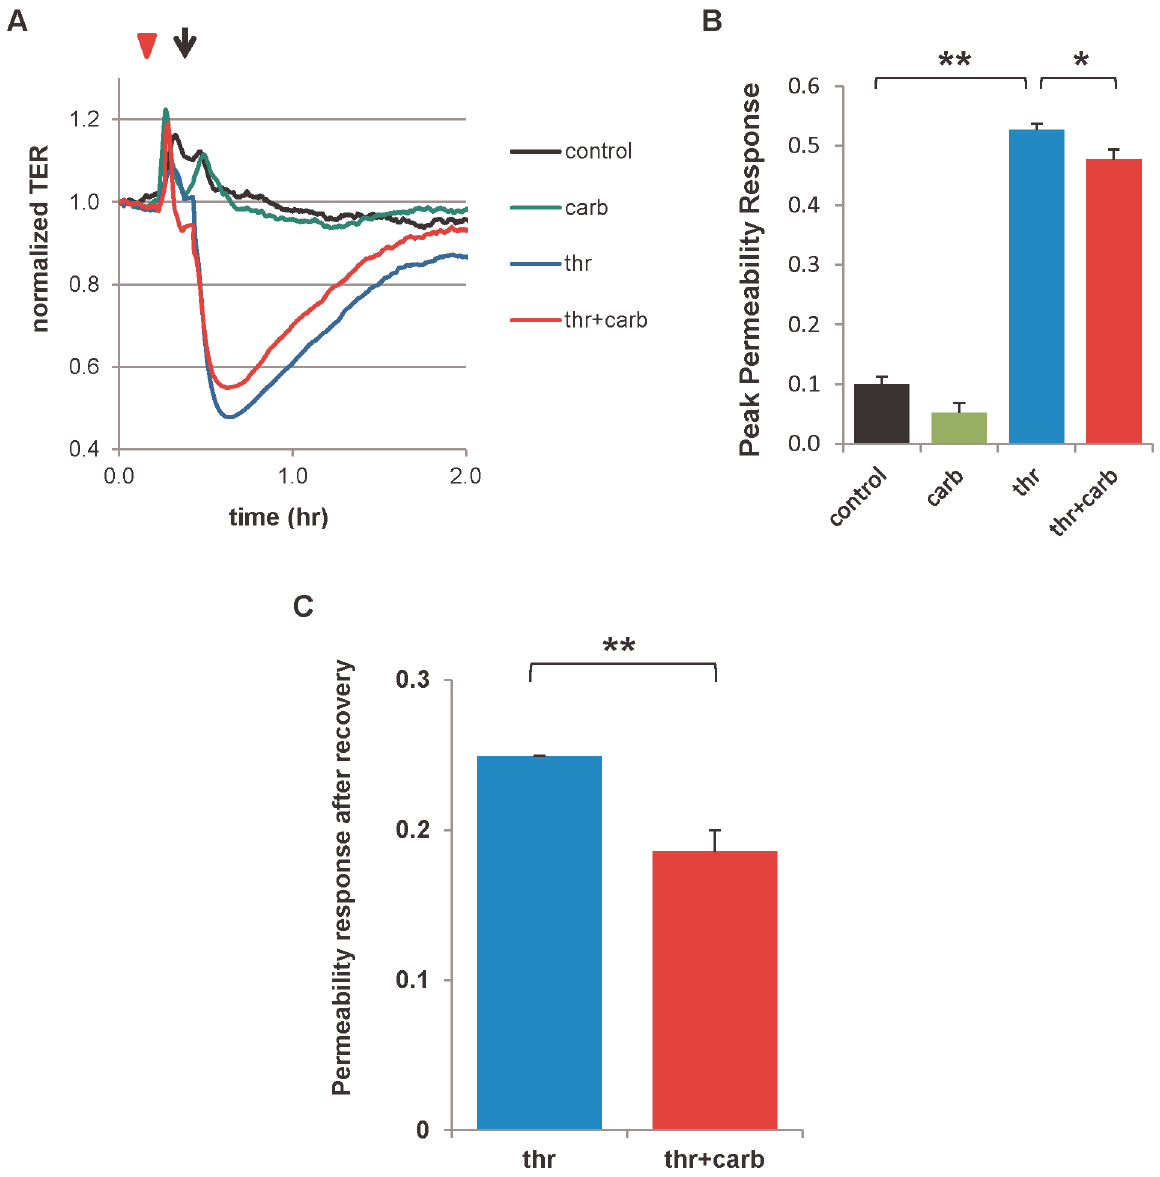
Figure 6. Gap junction inhibitor carbenoxolone attenuates permeability response to thrombin. Confluent HPAECs were treated with carbenoxolone (carb) for . 5 min (red triangle; 100 m M) followed by treatment with thrombin (arrow; 0.5 U/mL) and transendothelial resistance (TER) was measured. TER was recorded prior to any treatments and continued an additional 1.5 hr after treatments. A.) Representative TER traces are shown. B.) Peak permeability response is given as [1–(minimum normalized TER)], where normalization is to TER at the time point just prior to the first treatment. **, p , 0.001; *, p , 0.05; n=13 for control, n=11 for carb alone, and n=15 for thr alone and thr + carb. C.) Permeability response after recovery is given as (1–normalized TER), where TER is taken at the time point in recovery where the thrombin alone group recovers to reach a permeability of , 0.25; this is roughly 1 hr after thrombin treatment. As before, TER is normalized to the time point just prior to the first treatment. *p , 0.001, n=13 for each group. Carb=carbenoxolone,